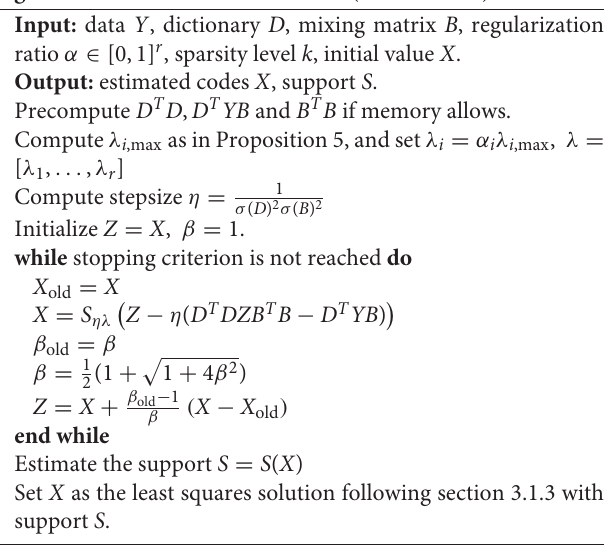
Algorithm 2 FISTA for Block LASSO